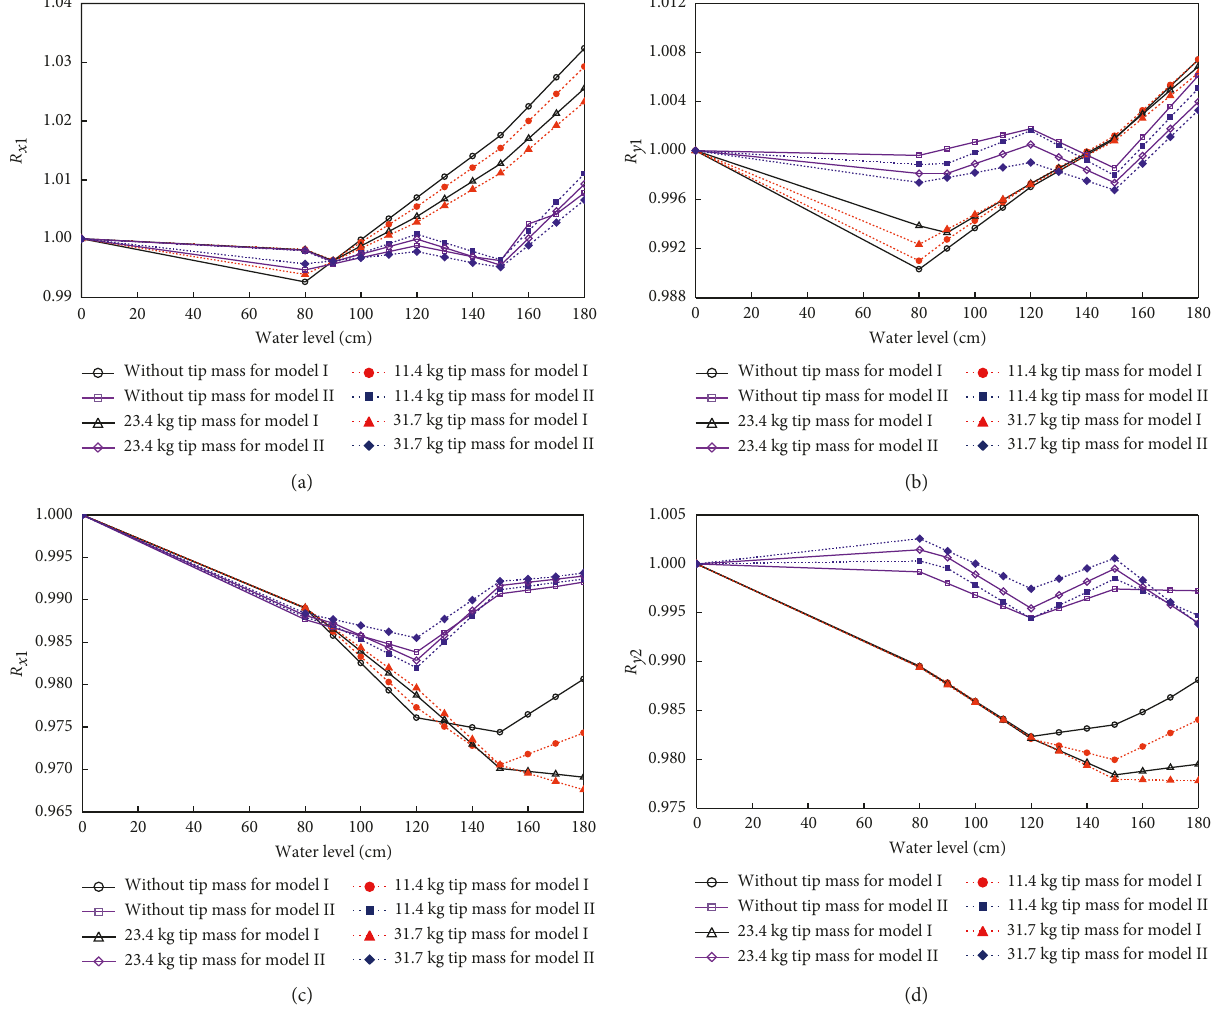
Figure 18: Vibration period ratios of the specimen in case I as a function of water level correspond to (a) first mode along the x -axis; (b) first mode along the y -axis; (c) second mode along the x -axis; and (d) second mode along the y